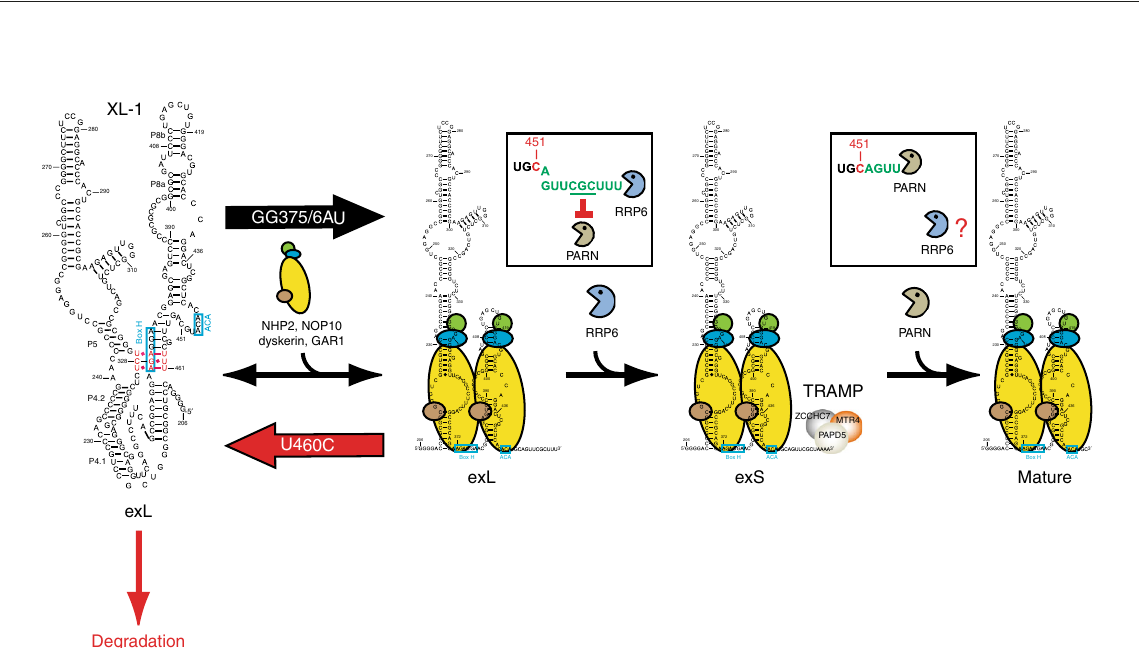
Fig. 6 Model. Schematic illustrating the multiple roles of the H/ACA complex and the different functions for RRP6, the exosome, and PARN in human telomerase RNP biogenesis